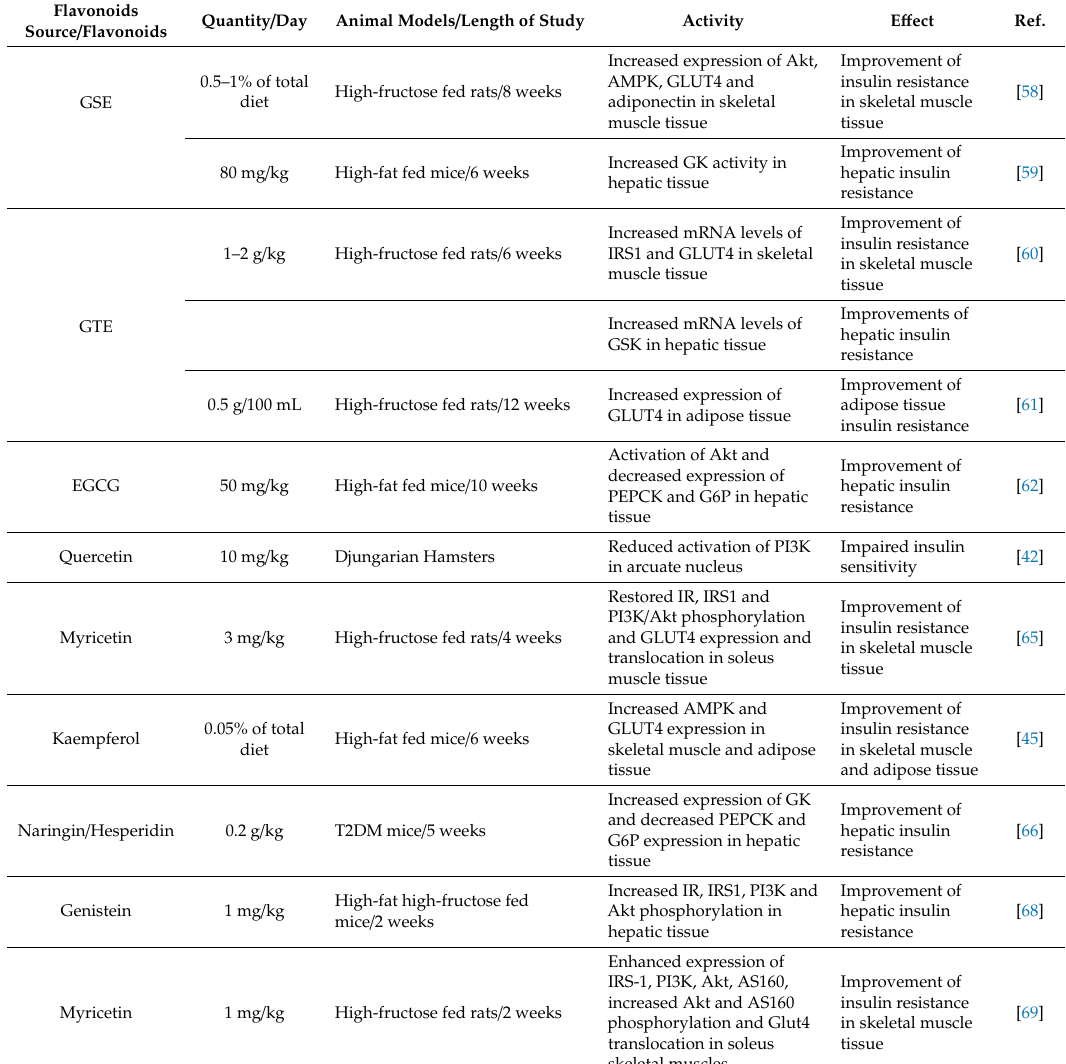
Table 4. E ff ects of flavonoids on insulin sensitivity in in vivo